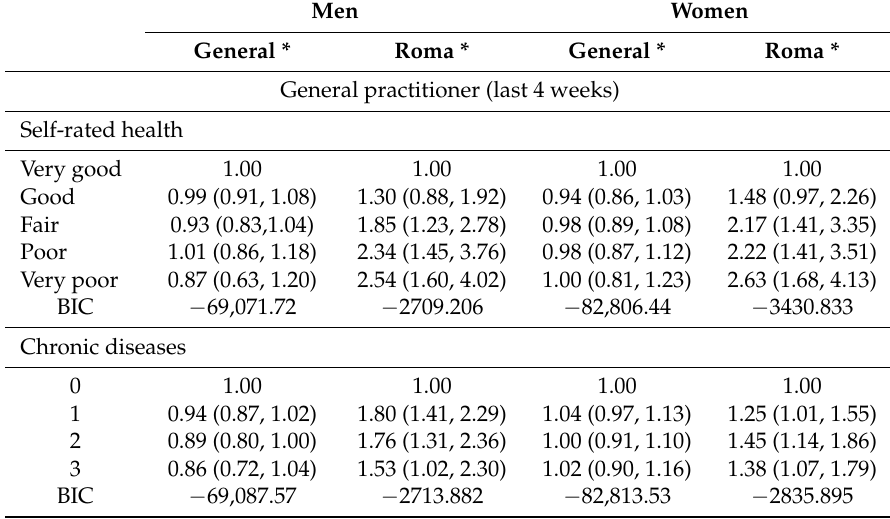
Table 4. Prevalence ratios (with 95% CI) for general practitioner utilization according to health need (self-rated health and comorbidity), stratified by general/Roma population and gender. Men Women General * Roma * General * Roma * General practitioner (last 4